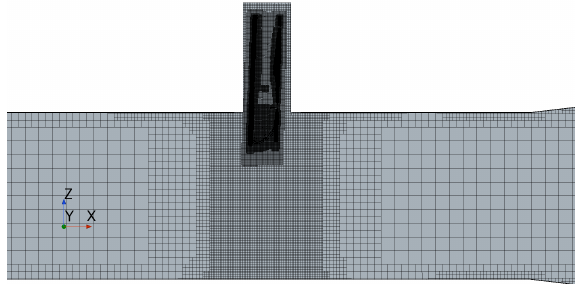
Figure 20. The structure of the mesh at a the foil region.